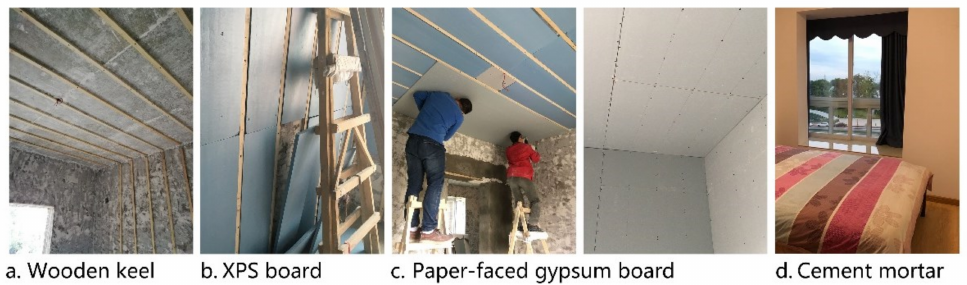
Figure 7. Overall view of the retrofit construction process. A comparison of the configuration of all opaque enclosures (exterior walls, interior walls, ceiling, and floor) in the south bedroom of the original and retrofitted unit is shown in Figure 8.